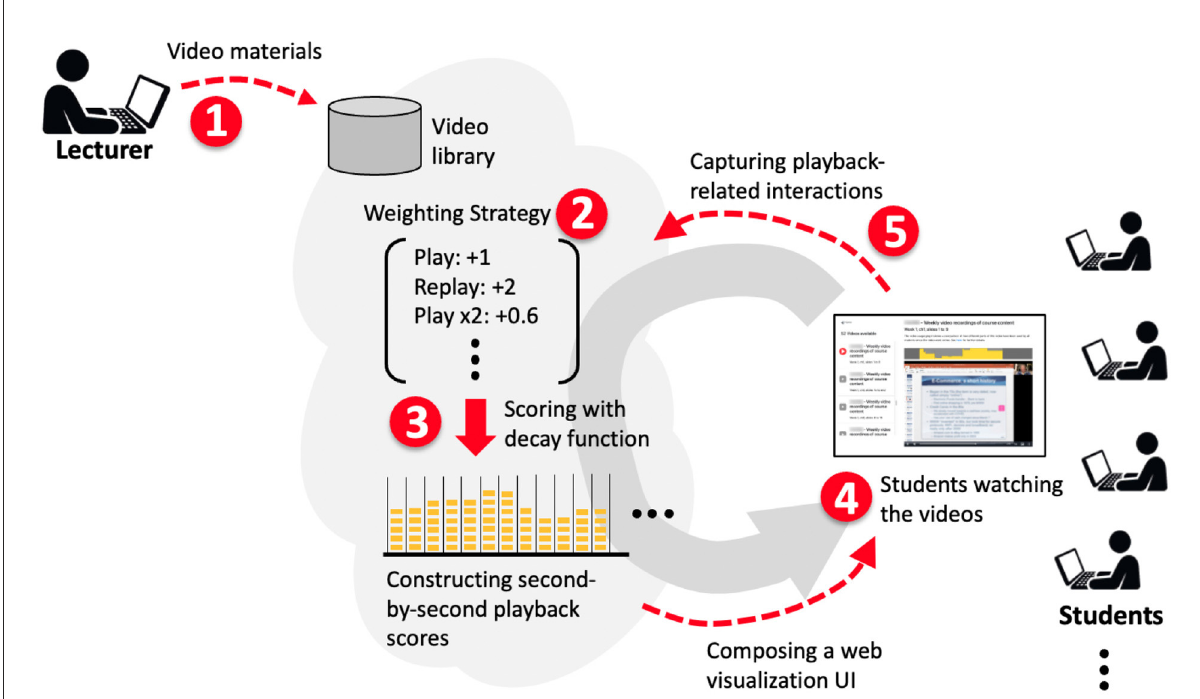
FIGURE1 Diagram of how the system works: once the video materials are uploaded (1), the remaining processes in the (2)-(3)-(4)-(5) cycle iterates as the resulting visualization contour evolves over